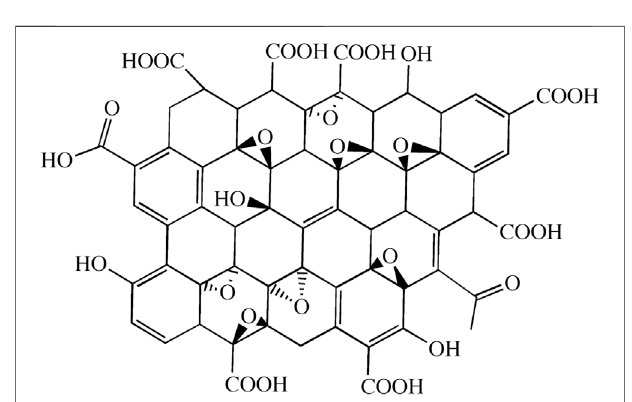
FIGURE 2 | Structure of graphene oxide (Zhou et al.,